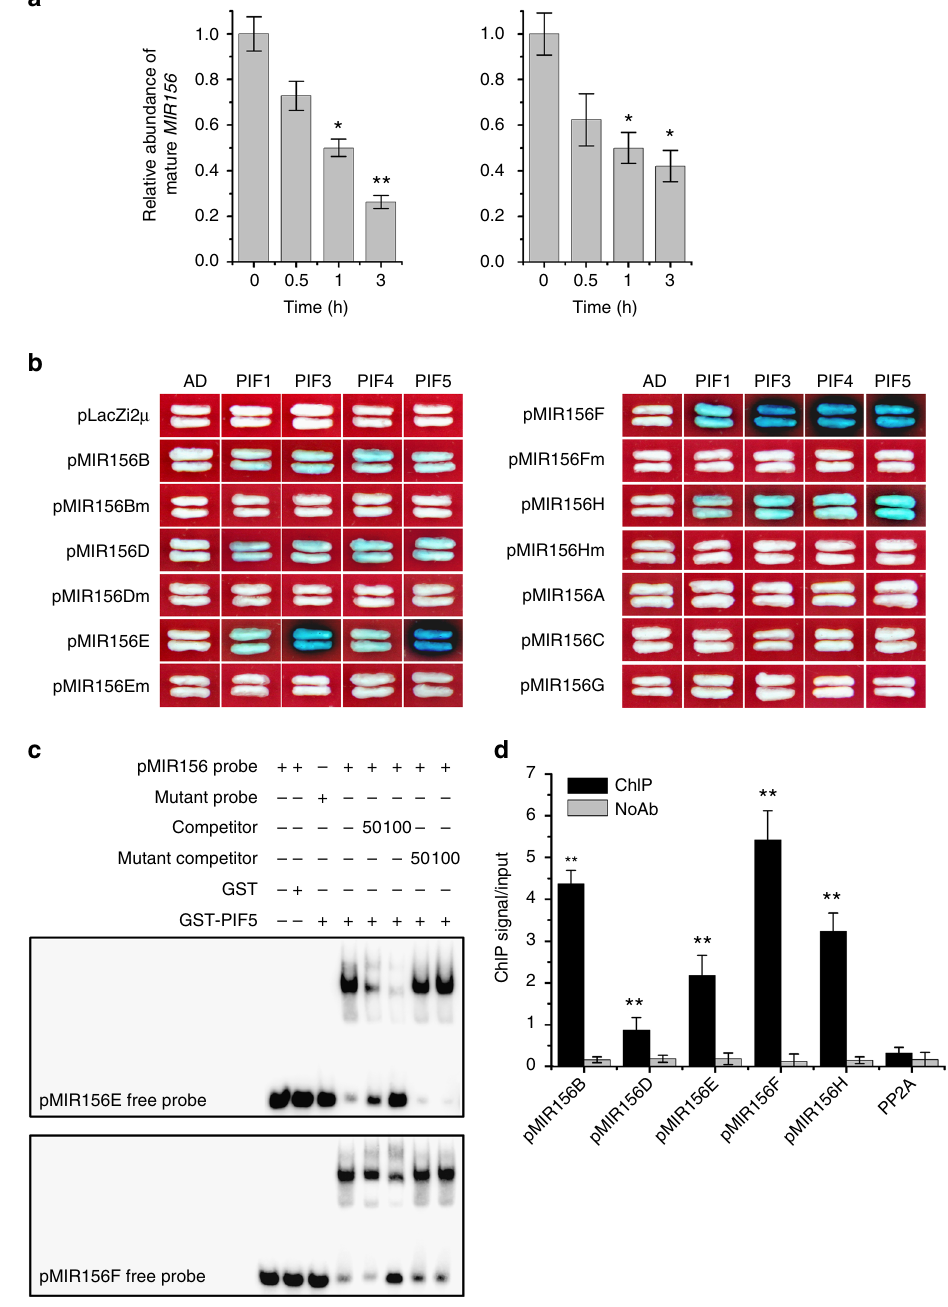
Fig. 3 PIFs directly bind to MIR156 promoters. a The transcript levels of mature MIR156 decline in WT in response to EOD-FR treatment. Eight-day-old ( left panel ) or 3-week-old ( right panel ) WT plants grown under WL were treated with or without EOD-FR for 6 days before harvested for RNA extraction. Values given are mean ± SD ( n = 3). * P < 0.05 and ** P < 0.01 by the Student ’ s t -test. b Y1H assay showing direct binding of PIFs to the PBE-box or G-box motifs in several MIR156 promoters. The length and PIF-binding elements of each promoter fragment is shown in Supplementary Fig. 6. c EMSA showing that the GST-PIF5 bHLH domain recombinant protein binds to biotin-labeled probes of MIR156E ( up panel ) and MIR156F ( down panel ). d ChIP assay of MIR156 in 2- week-old 35S::PIF5-HA seedlings grown under high R:FR conditions and treated with EOD-FR for one time before harvesting. Values given are mean ± SD ( n = 3). ** P < 0.01 by the Student ’ s t